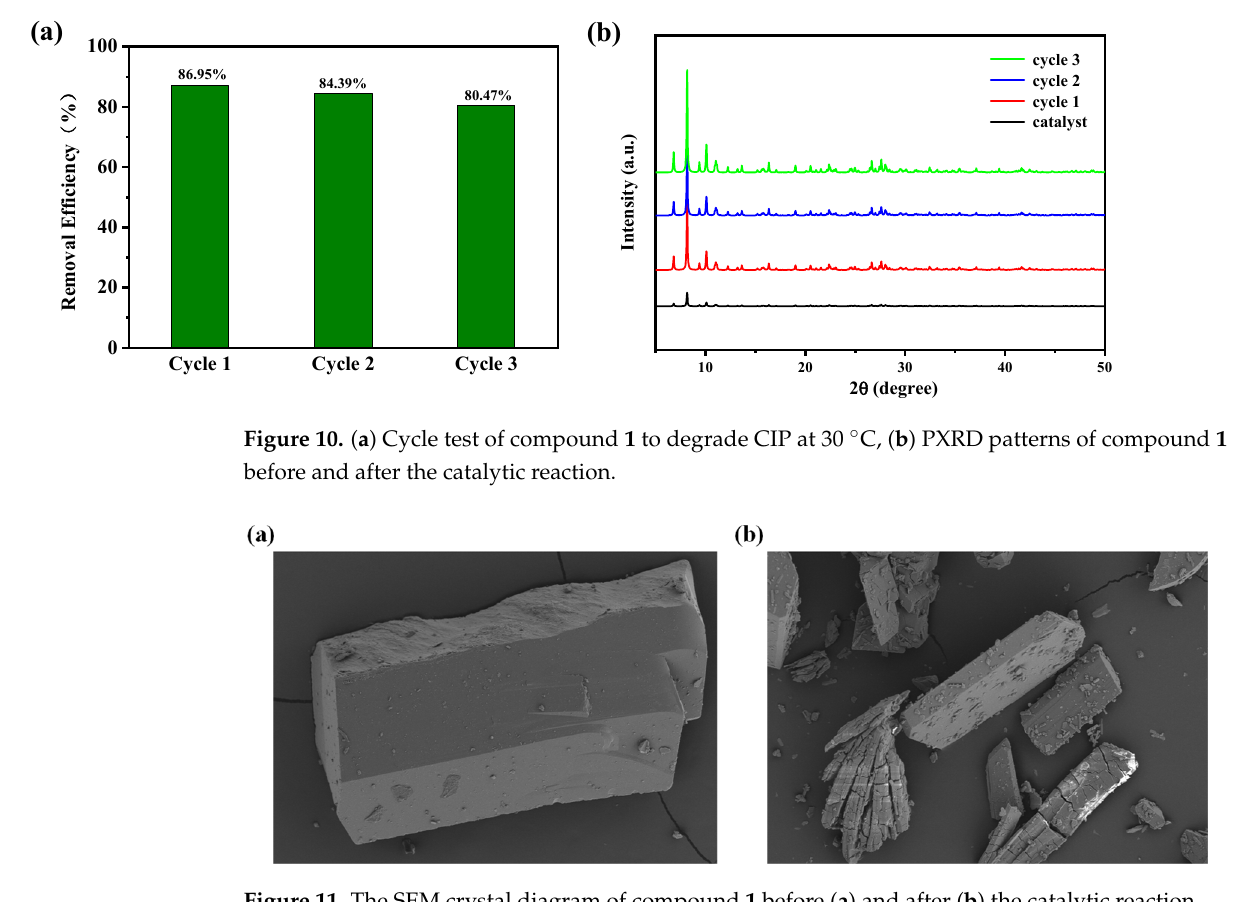
9 of 13 Figure 9. ( a ) Effect of catalyst 1 dosage, ( b ) Degradation rate of compound 1 to ciprofloxacin under different doses. To investigate the practical value of compound 1 in photocatalytic degradation of CIP, we explored the regeneration and stability of compound 1 . The photocatalytic sta- bility of compound 1 is shown in Figure 10. After the photocatalytic degradation of CIP solution finished, compound 1 was collected. The surface was cleaned with deionized water to remove the residual CIP in the previous experiment, and then put the collected compound 1 into the fresh CIP solution to start a new cycle. The stability and reusability of compound 1 for degradation of CIP was investigated by three consecutive cycles. In the cycle experiment, all experimental conditions were exactly the same as the first ex-